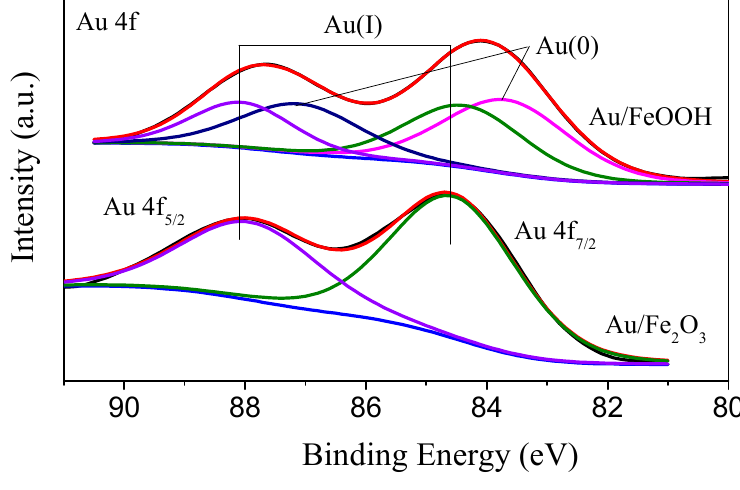
Figure 6. Au 4f XP spectra of the catalysts.